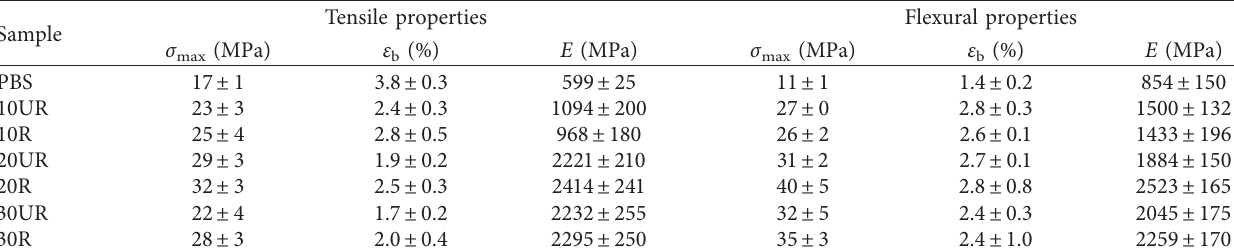
Table 8: Tensile and flexural properties of hemp fibre-reinforced PBS composites [57].